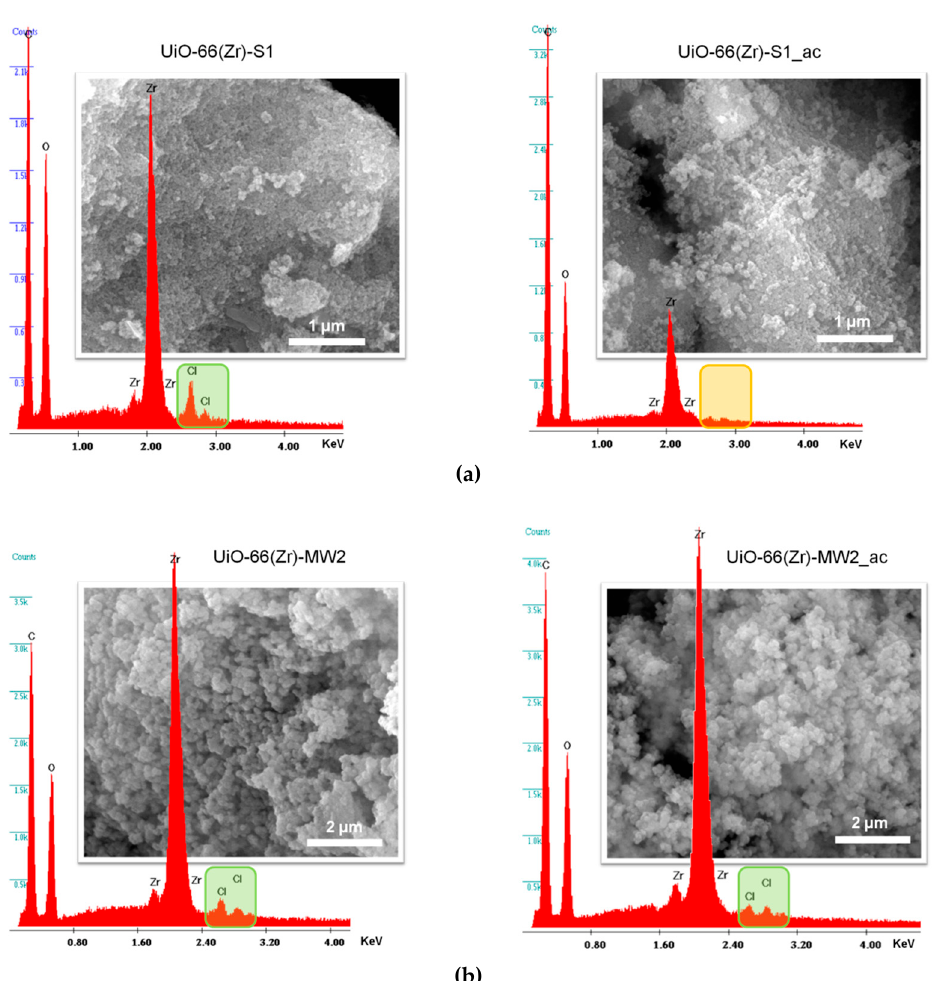
Figure 8. EDS spectra and SEM images of the UiO-66(Zr)-S1 ( a ) and UiO-66(Zr)-MW2 ( b ) materials in comparison with those after catalytic use [UiO-66(Zr)-S1_ac and UiO-66(Zr)-MW2_ac].